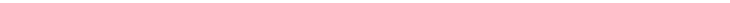
Algorithm 3: Build a Route Summary